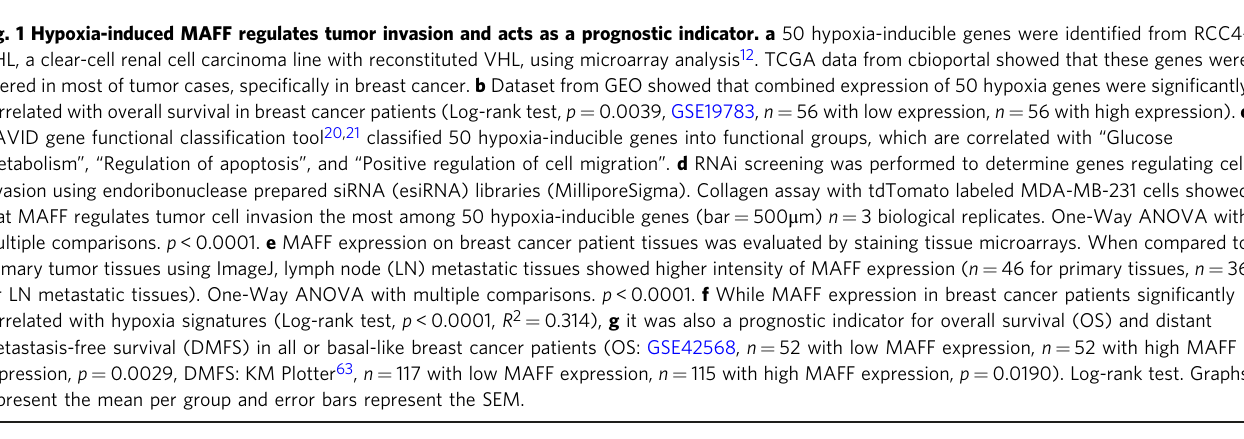
Fig. 1 Hypoxia-induced MAFF regulates tumor invasion and acts as a prognostic indicator. a 50 hypoxia-inducible genes were identi fi ed from RCC4- VHL, a clear-cell renal cell carcinoma line with reconstituted VHL, using microarray analysis 12 . TCGA data from cbioportal showed that these genes were altered in most of tumor cases, speci fi cally in breast cancer. b Dataset from GEO showed that combined expression of 50 hypoxia genes were signi fi cantly correlated with overall survival in breast cancer patients (Log-rank test, p = 0.0039, GSE19783, n = 56 with low expression, n = 56 with high expression). c DAVID gene functional classi fi cation tool 20,21 classi fi ed 50 hypoxia-inducible genes into functional groups, which are correlated with “ Glucose Metabolism ” , “ Regulation of apoptosis ” , and “ Positive regulation of cell migration ” . d RNAi screening was performed to determine genes regulating cell that MAFF regulates tumor cell invasion the most among 50 hypoxia-inducible genes (bar = 500 μ m) n = 3 biological replicates. One-Way ANOVA with multiple comparisons. p < 0.0001. e MAFF expression on breast cancer patient tissues was evaluated by staining tissue microarrays. When compared to primary tumor tissues using ImageJ, lymph node (LN) metastatic tissues showed higher intensity of MAFF expression ( n = 46 for primary tissues, n = 36 for LN metastatic tissues). One-Way ANOVA with multiple comparisons. p < 0.0001. f While MAFF expression in breast cancer patients signi fi cantly correlated with hypoxia signatures (Log-rank test, p < 0.0001, R 2 = 0.314), g it was also a prognostic indicator for overall survival (OS) and distant metastasis-free survival (DMFS) in all or basal-like breast cancer patients (OS: GSE42568, n = 52 with low MAFF expression, n = 52 with high MAFF expression, p = 0.0029, DMFS: KM Plotter 63 , n = 117 with low MAFF expression, n = 115 with high MAFF expression, p = 0.0190). Log-rank test.